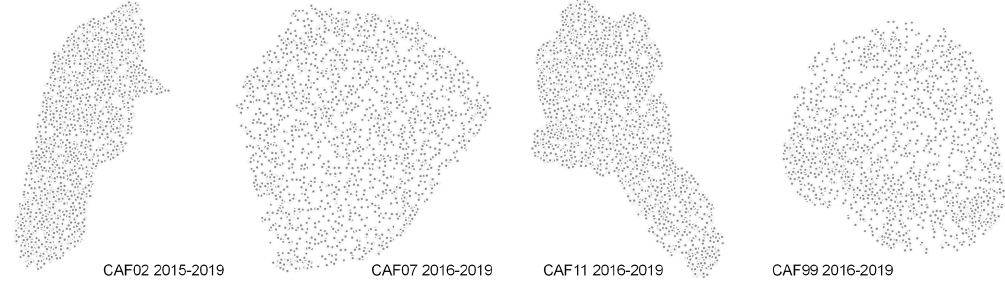
Figure 3. Spatial distribution of the validation datasets within the updated key landscapes for conservation.